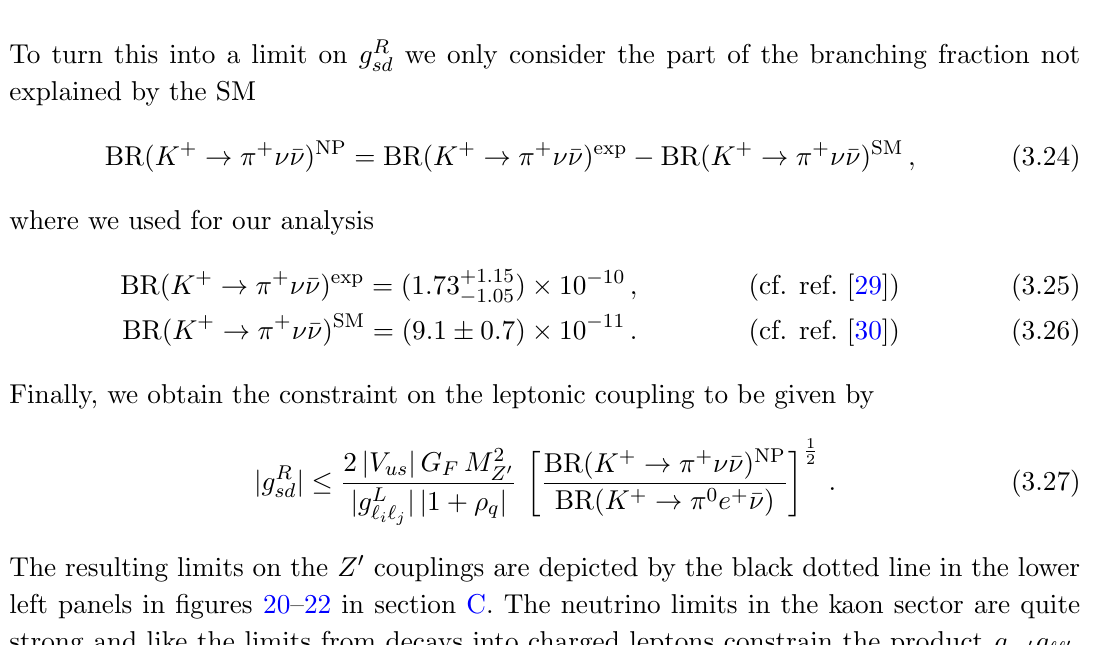
Figure 10 . (Left) Decay B 0 ! (cid:25) 0 (cid:22) (cid:23) i (cid:23) j mediated by the Z 0 boson. (Right) SM decay B 0 ! (cid:25) (cid:0) e + (cid:23) e mediated by the W